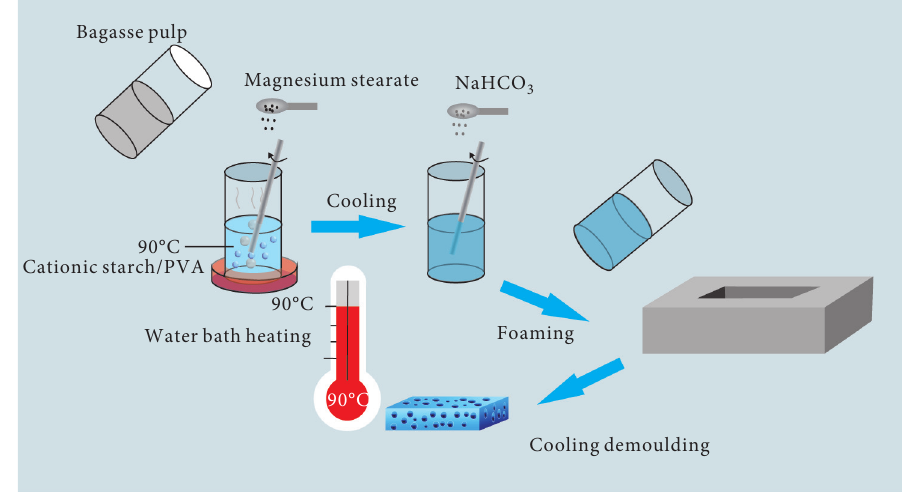
Figure 1: Flow chart of the preparation of foam